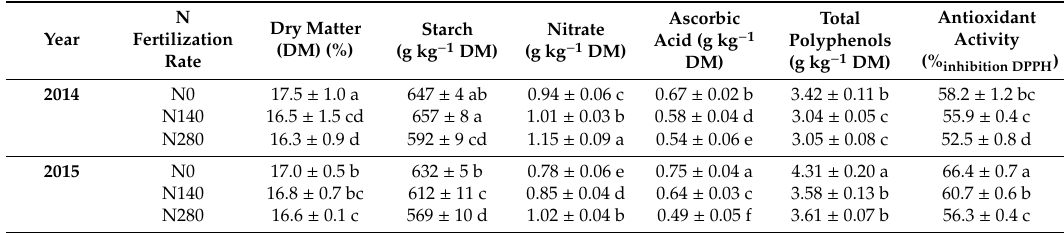
Table 6. Chemical composition of early potato tubers as a ff ected by the interaction between year and nitrogen fertilization rate. Di ff erent letters within each column indicate statistically significant di ff erences (LSD test, p <